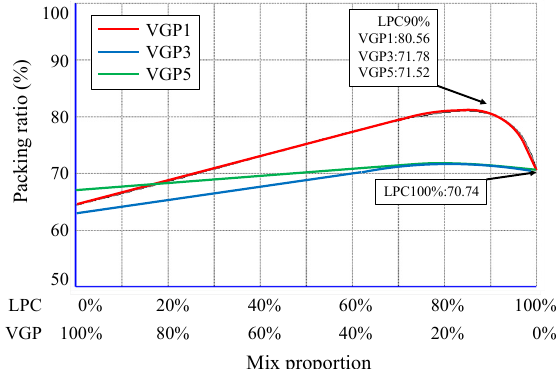
Figure 10. Calculated packing ratio.